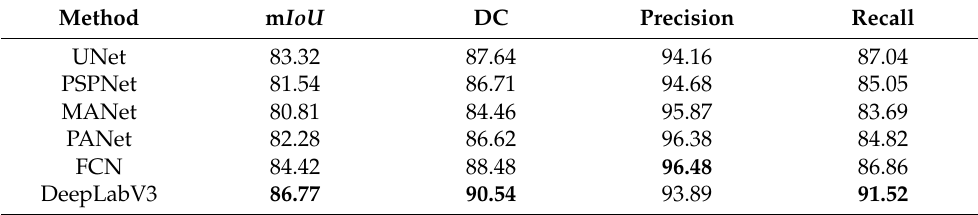
Table 3. Segmentation performance on the validation set using various evaluation metrics (%). Method m IoU DC Precision Recall UNet 83.32 87.64 94.16